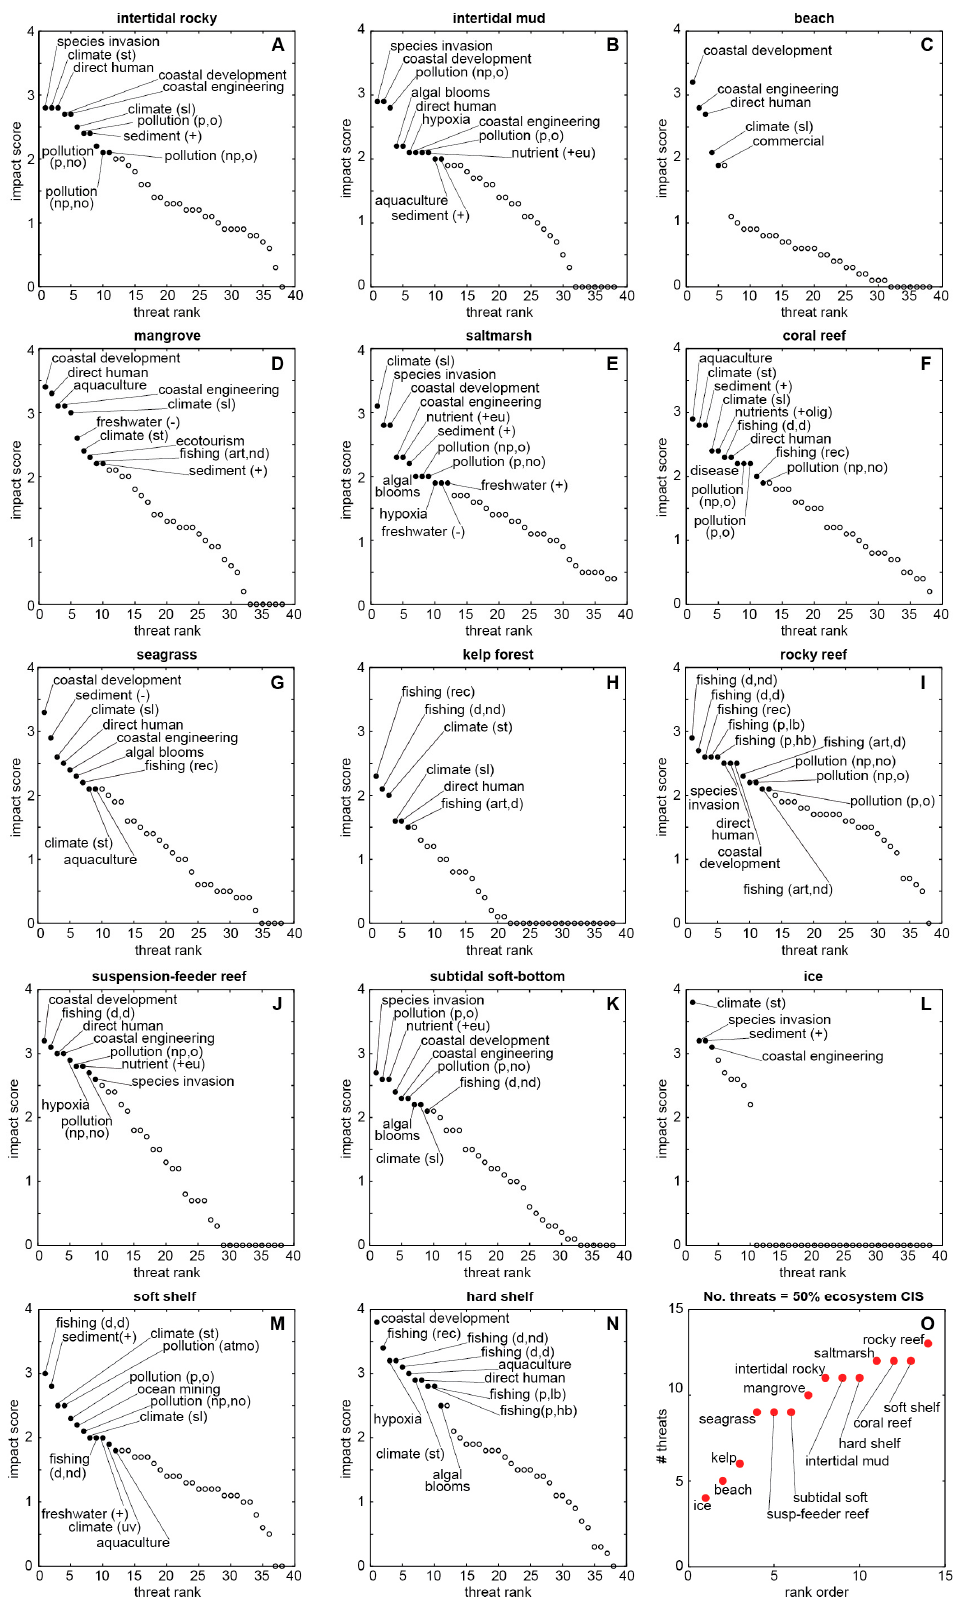
Figure 3. ( A – N ) Ranked threats per coastal ecosystem (Figure 2A). Labelled threats, when summed, account for the top 50% of the total threat score for a given ecosystem (Figure 2B). ( O ) Ecosystems ranked (lowest to highest) by number of threats that contribute to the 50% totals in panels (A–N).